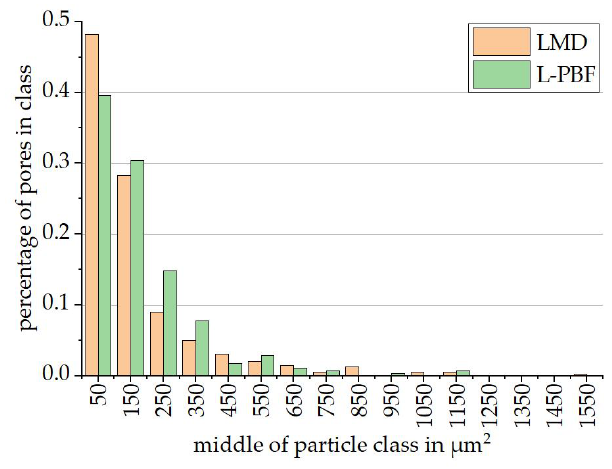
Figure 8. Comparison of the particle pore distribution of LMD and L-PBF manufactured specimens.